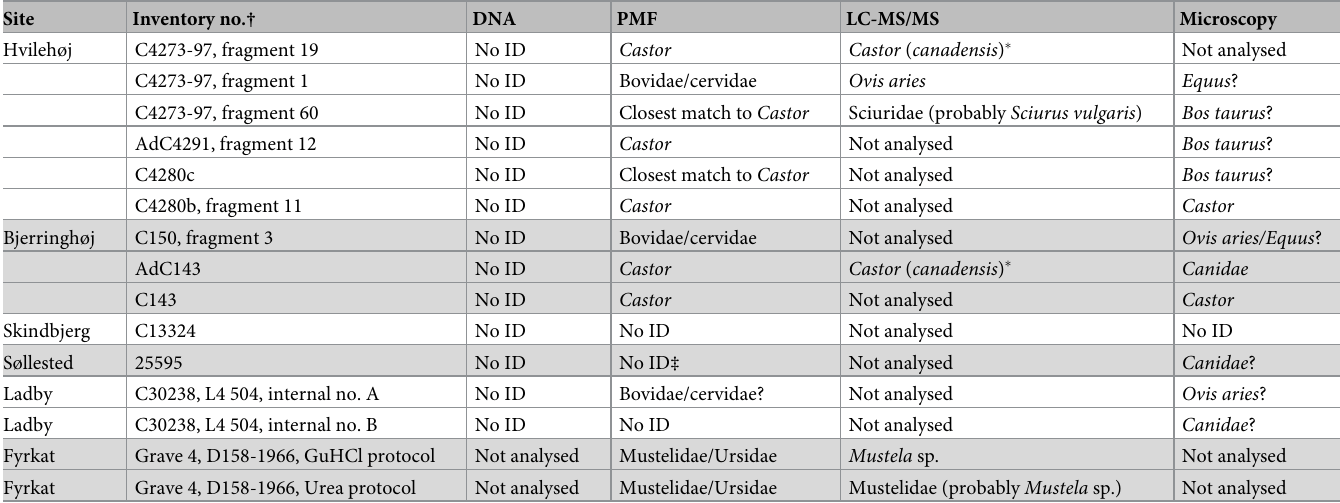
Table 1. Identifications of samples based on DNA, PMF, LC-MS/MS, and hair